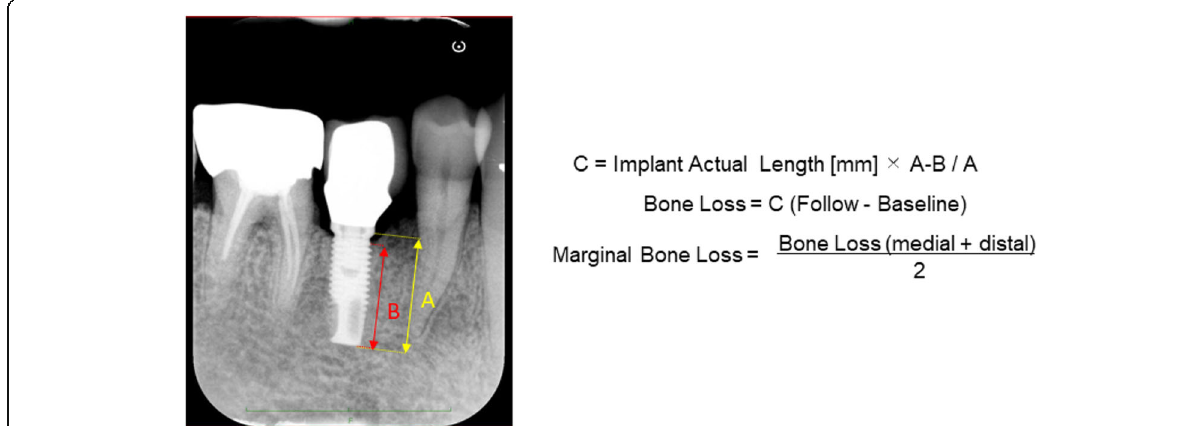
Fig. 2 Measurement of marginal bone loss (MBL) on dental radiography. MBL is measured using Image J software (National Institutes of Health, Bethesda, MD, USA). The reference points for the measurements are the implant platform (the horizontal interface between the implant and the abutment), the implant tip, and the first bone-implant contact (FBIC). The length from the implant platform to the FBIC defines the marginal bone level. The marginal bone level is measured in mm using the ratio of the real implant length and the length from the implant platform